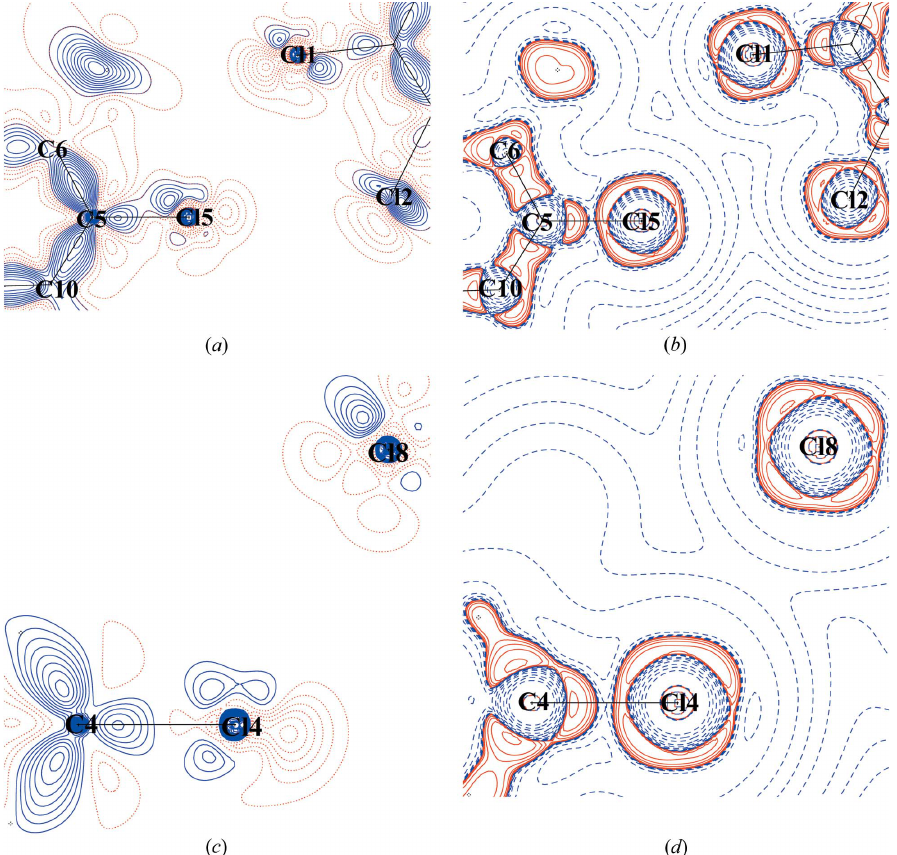
Figure 10 ( a ) Two-dimensional deformation density; ( b ) two-dimensional Laplacian plot of the intermolecular Cl5 (cid:2)(cid:2)(cid:2) Cl4 interaction region; ( c ) two-dimensional deformation density; ( d ) two-dimensional Laplacian plot of the intermolecular Cl4 (cid:2)(cid:2)(cid:2) Cl8 interaction region. Blue (solid lines) and red (broken lines) colours represent positive, negative contours respectively (reversed in case of Laplacian). Contours are drawn at intervals of (cid:9) 0.05 e A˚ (cid:6) 3 . The Laplacian is plotted on logarithmic contours.